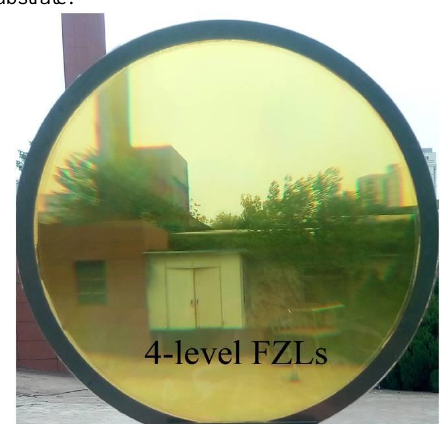
By using the self-aligned method, a 4-level membrane FZL in 200 mm diameter was made. Figure 4 shows a 4-level membrane FZLs in 200 mm diameter successfully released from substrate.